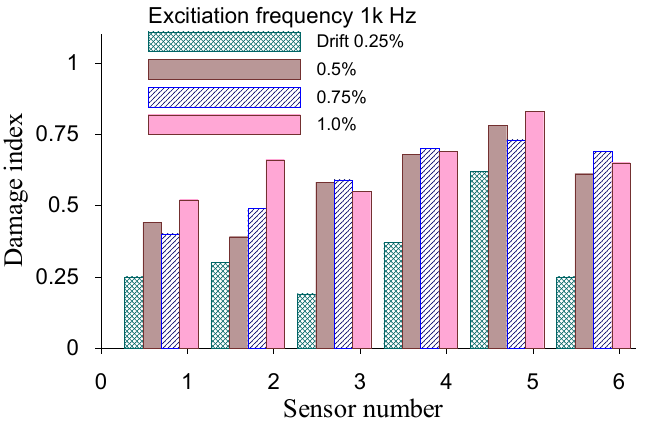
Figure 16. Damage index at each drift ratio for RCW2 (excitation frequency 1 kHz).